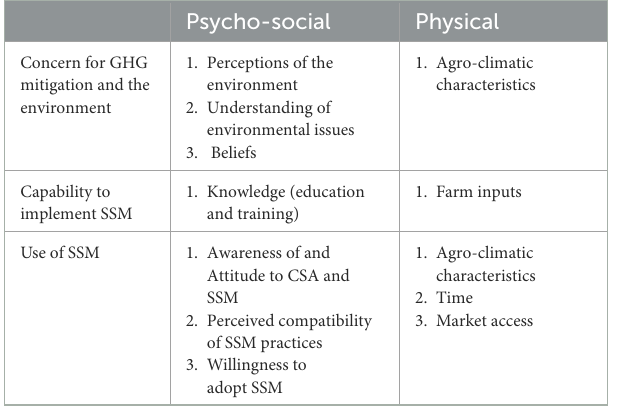
TABLE 4 Major facilitators of and barriers to SSM in coastal and hinterland cohorts.